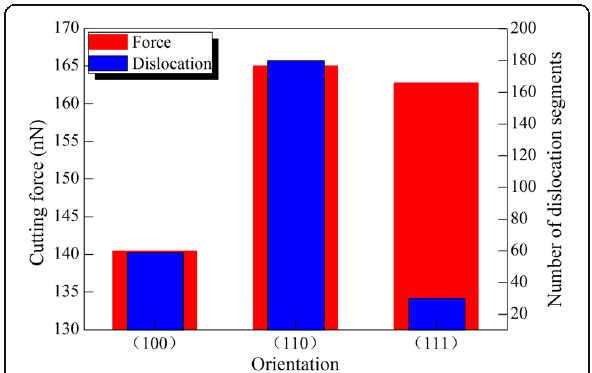
Fig. 9 Crystal orientation dependence of cutting force and dislocation number; (color online) crystal orientation dependence of cutting force and dislocation